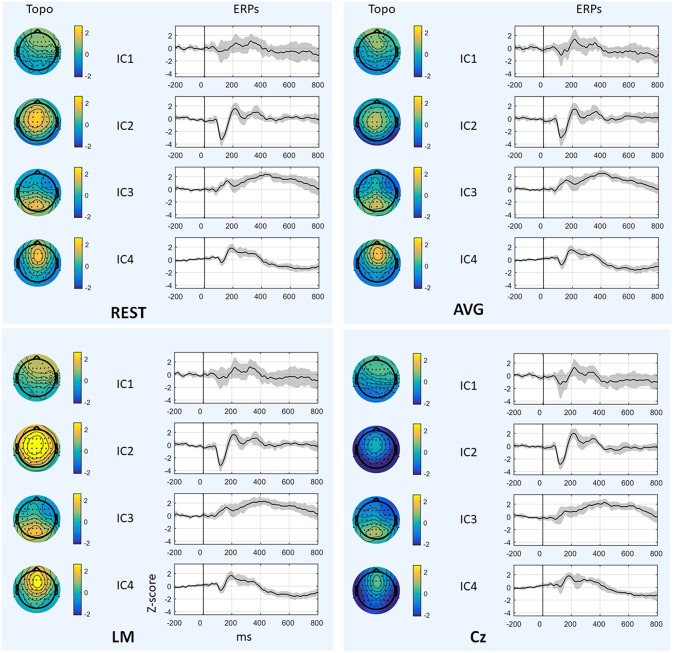
Results of real data. The mean ERPs and topographic maps of each ICA component (IC1–IC4) for REST, AVG, LM, and Cz references are shown separately. The gray region in ERPs represents standard deviation across subjects.